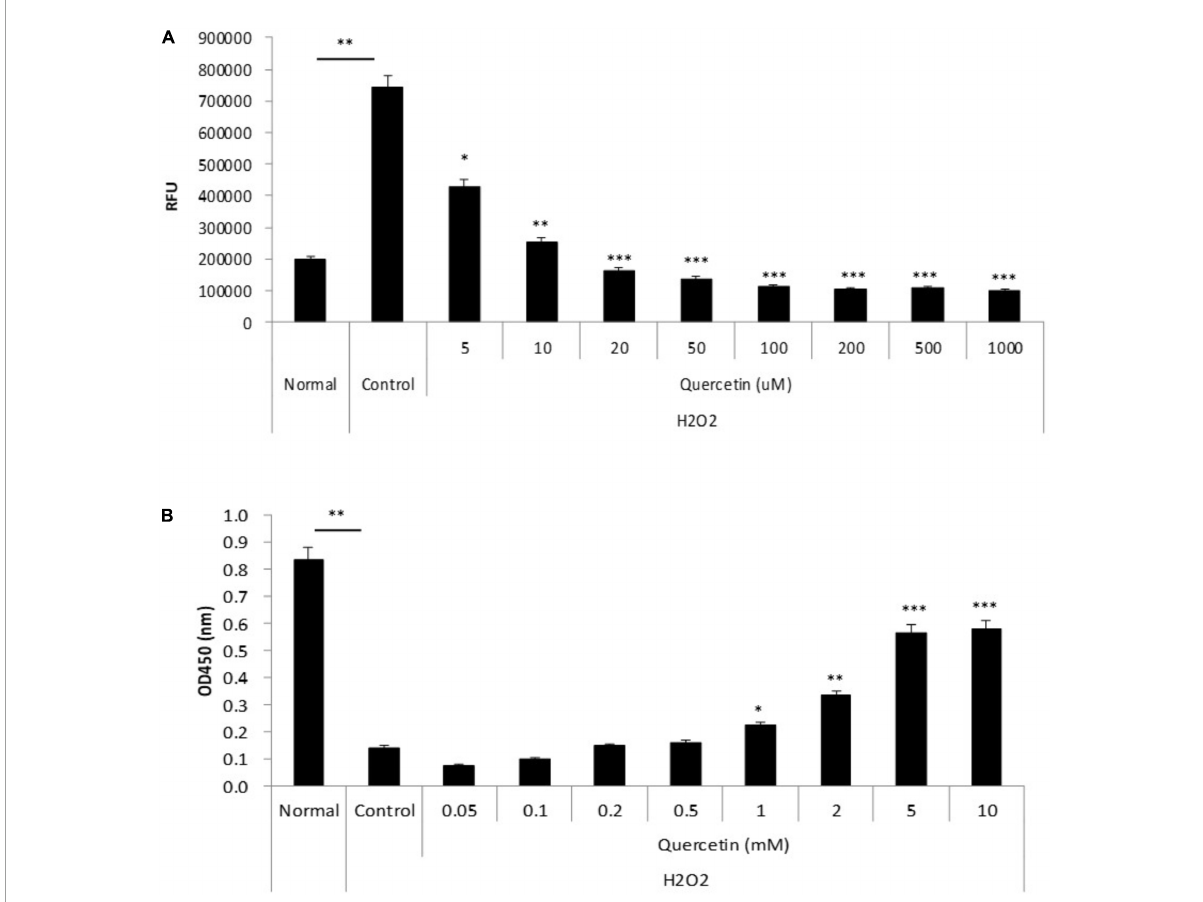
FIGURE4 Anti-oxidant effect of quercetin by oxidative stress in vitro . (A) TKE2 cells were seeded into 96-well plates (1 × 10 4 cells/well) and cultured for 2 days. After quercetin and H 2 O 2 treatment, ROS production was detected by measurement of the fluorescence intensity using a plate reader. (B) TKE2 cells were seeded into 96-well plates (2 × 10 3 cells/well) and cultured overnight. The cells were challenged with H 2 O 2 at 37 ◦ C for 72 h, and then treated with quercetin solution for 1 h. Cell viability of cell was assayed using WST-8. All data are presented as means ± SEM. Statistical analysis was carried out by the Mann–Whitney U -test, ∗∗∗ P < 0.001, ∗∗ P < 0.01, and ∗ P <